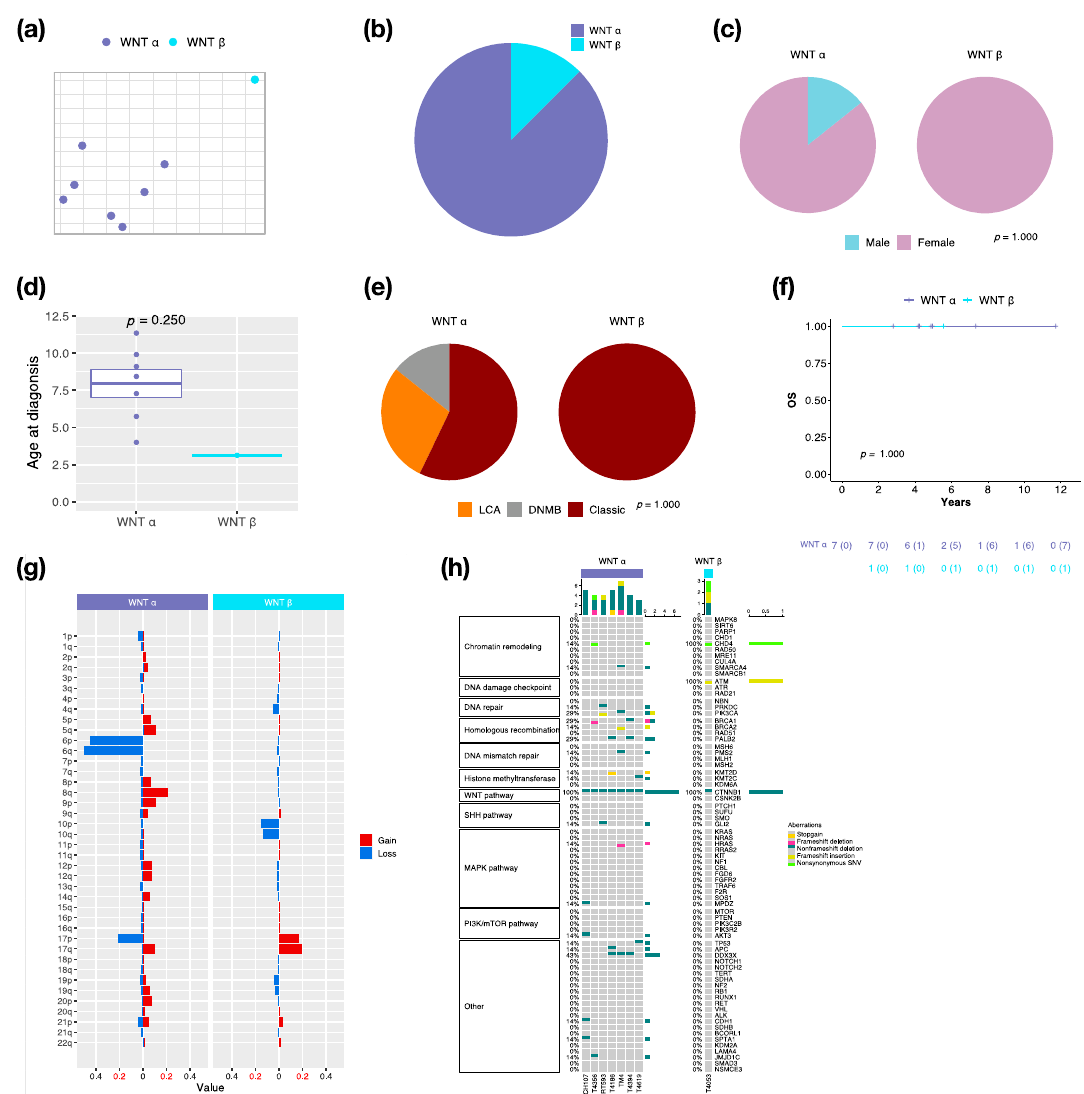
Figure 2. Characteristics in WNT MB subtypes. t-SNE dimensional distribution ( a ) and proportion ( b ) of WNT subtypes. Clinical features including gender ( c ), age ( d ), histology ( e ) in WNT subtypes. DNMB: desmoplastic/nodular medulloblastoma, LCA: large-cell/anaplastic. p value calculated by Fisher’s exact test. ( f ) overall survival (OS) across WNT subtypes. p value calculated by log-rank test. ( g ) Chromosomal aberrations in WNT subtypes. ( h ) Distribution of somatic mutations in WNT subtypes.